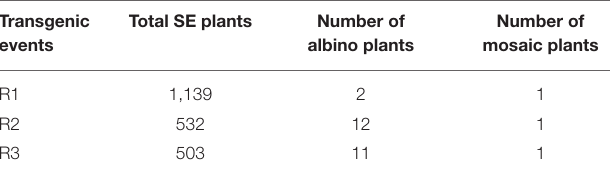
TABLE 2 | The frequency of the visible transgenic SE plants to the total regenerated